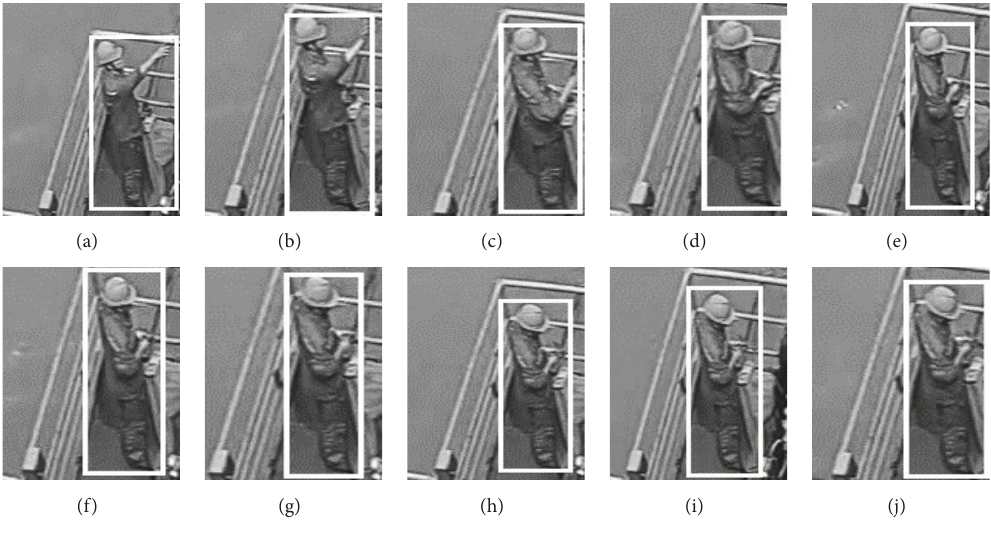
Figure 6: Scene detection of one person